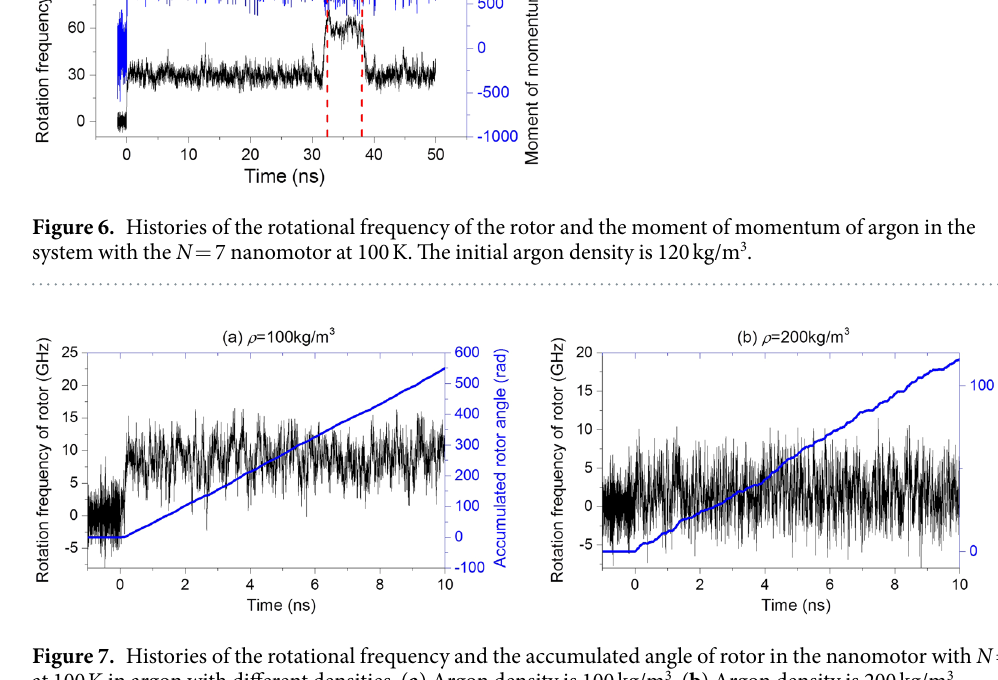
Figure 7. Histories of the rotational frequency and the accumulated angle of rotor in the nanomotor with N = 2 at 100 K in argon with different densities. ( a ) Argon density is 100 kg/m 3 . ( b ) Argon density is 200 kg/m 3